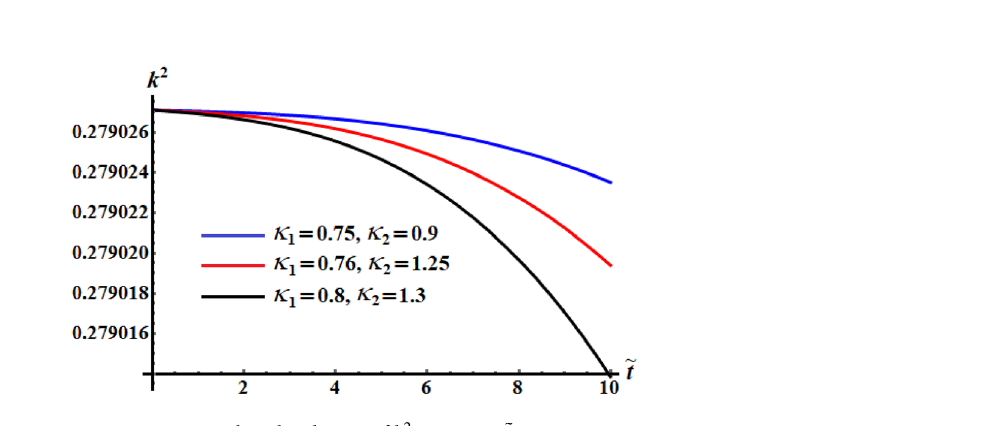
Figure 18. Reveals the variation of ˜ M with ˜ t at σ =